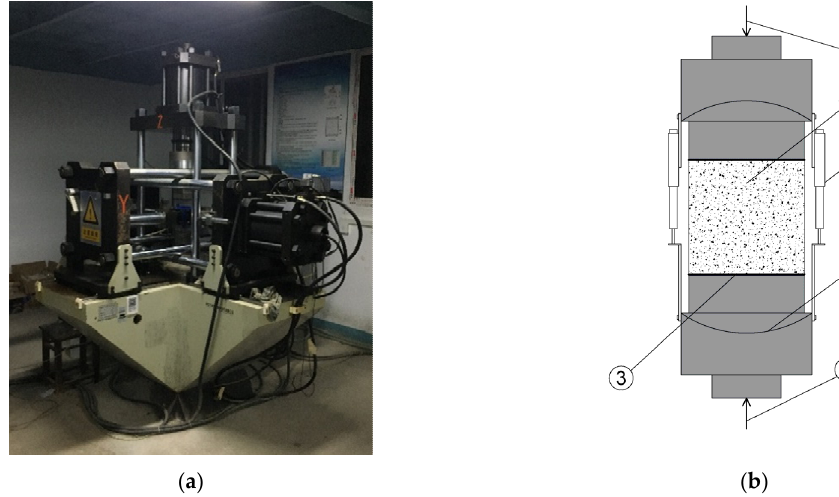
Figure 2. Diagrams of the test device and loading process. ( a ) loading test device; ( b ) schematic loading diagram of uniaxial compression tests: (1) concrete specimen; (2) load and displacement sensors (LVDT); (3) friction-reducing layers; (4) spherical hinges; (5) loading directions.